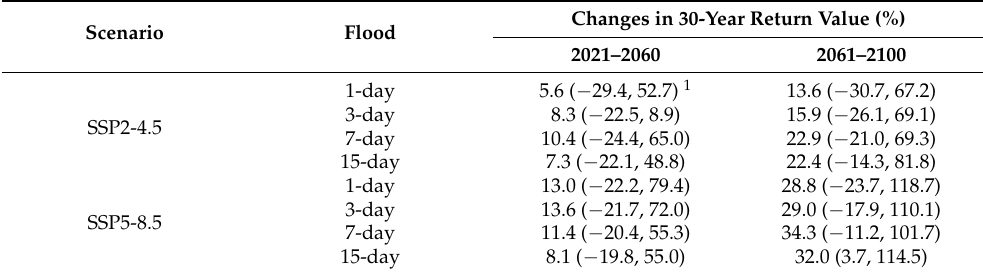
Table 5. Projected changes in flood volume of the 30-year return value of 1-, 3-, 7-, and 15-day floods in the Fujiang River basin for 2021–2060 and 2061–2100 under 14 GCMs and 2 SSP-RCPs (relative to 1971–2010).